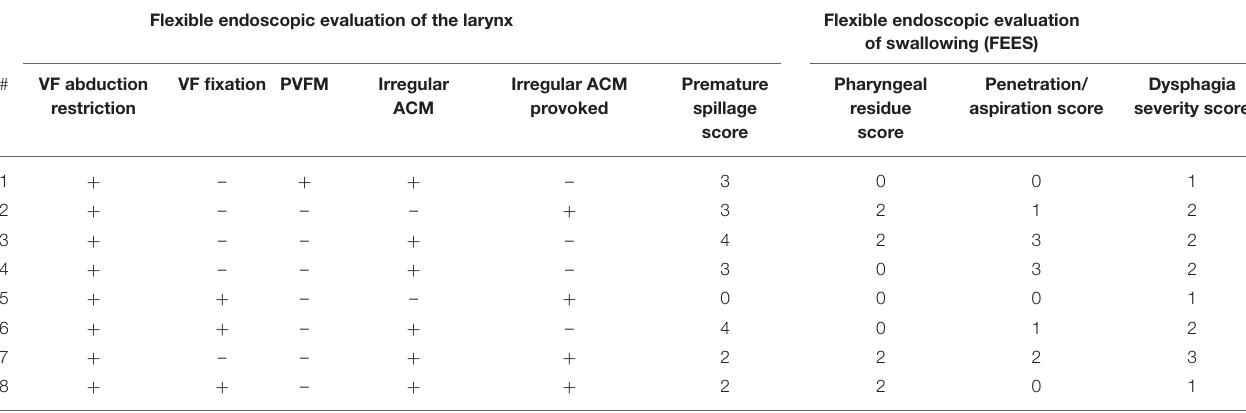
TABLE 6 | Endoscopic pharyngolaryngeal findings performing the MSA-FEES-protocol in 8 MSA patients. Flexible endoscopic evaluation of the